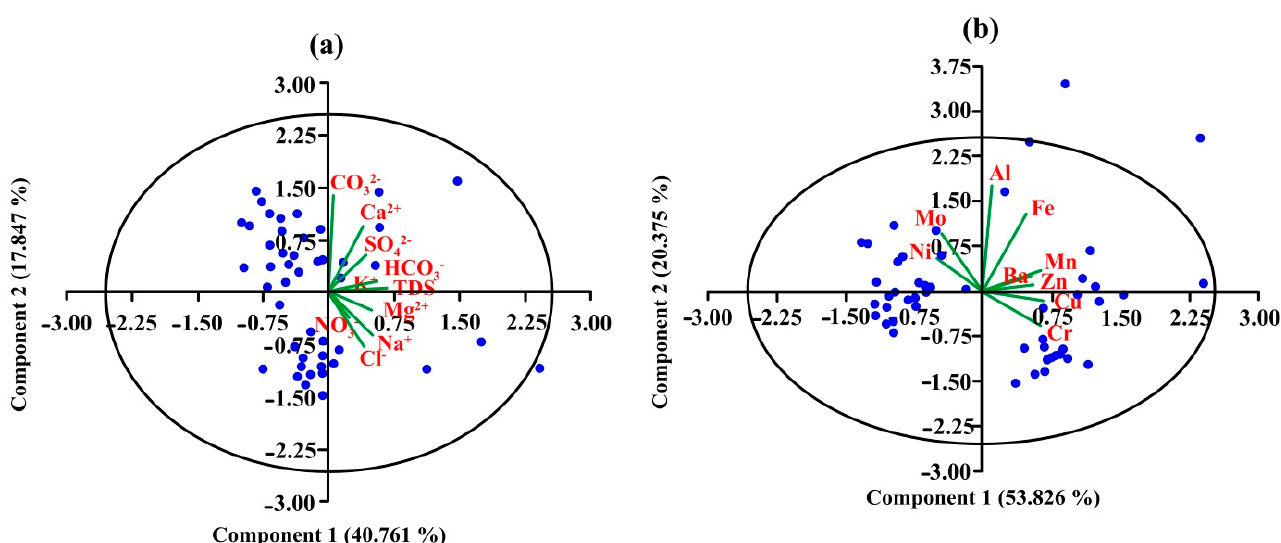
Figure 8. Principal component analysis of physicochemical parameters along the Nile River: ( a ) PCA of major ions and ( b ) PCA of trace elements and metals.